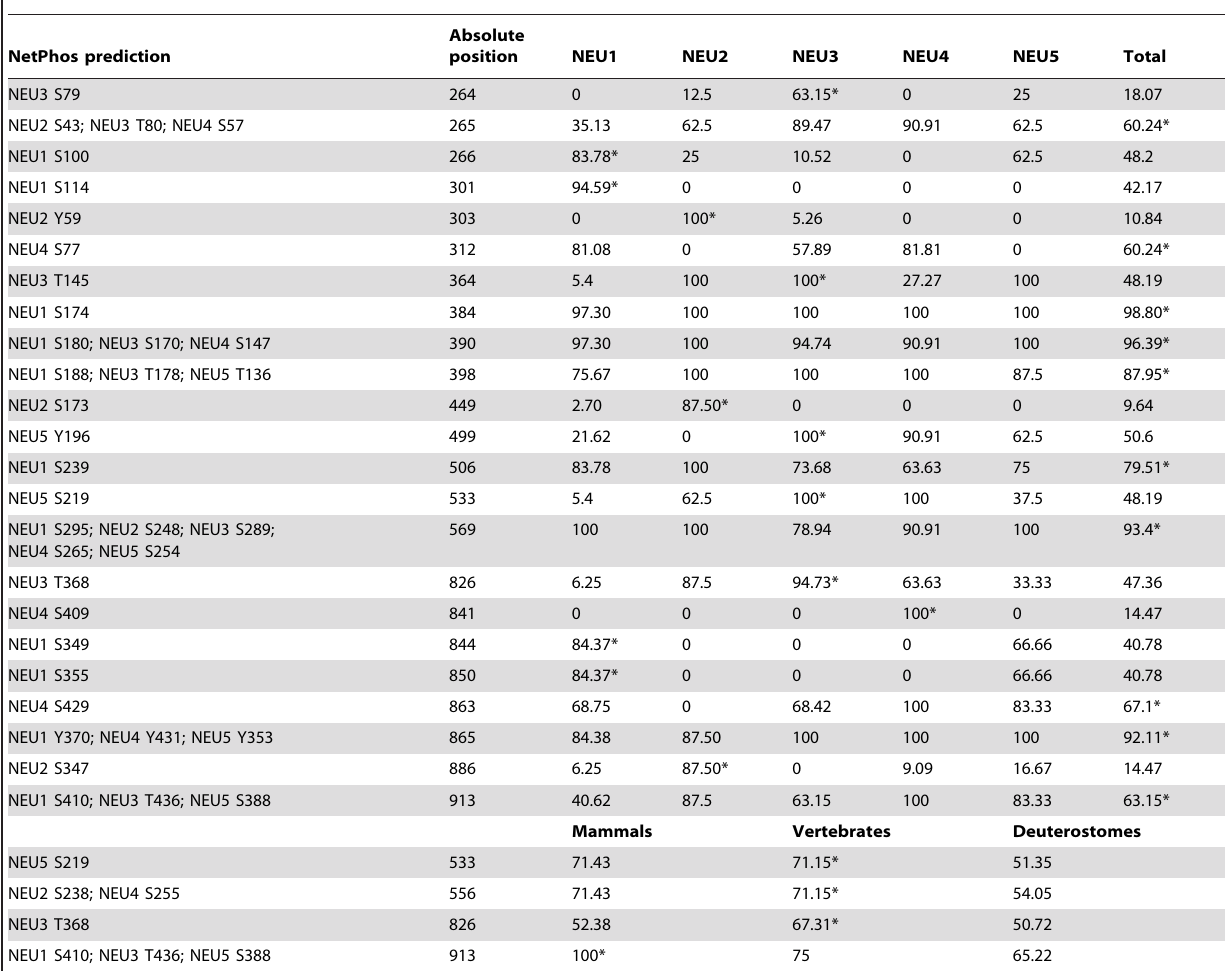
Table 4. Conservation of phosphorylatable